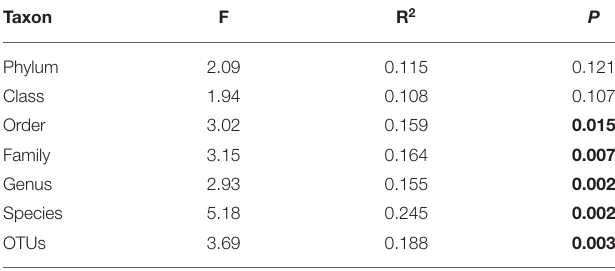
TABLE 3 | The significance analysis of community structure differences (using the ADONIS test) between groups under the two silicon (Si) treatments with different taxon